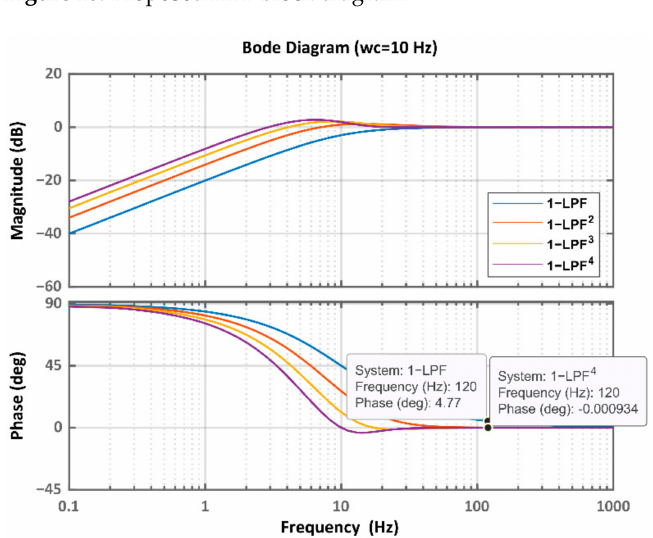
Figure 11. Frequency analysis for proposed